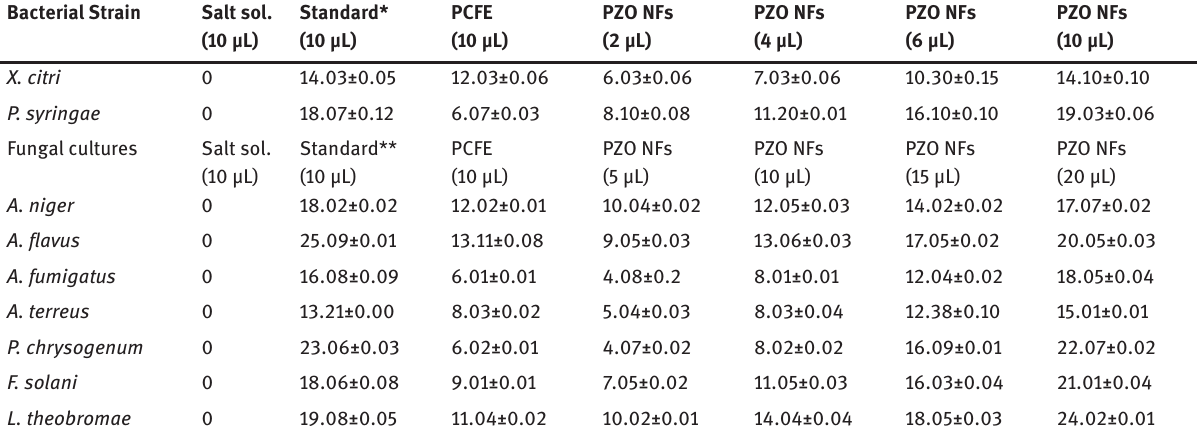
Table 2: In vitro antibacterial and antifungal efficacy of pomosynthesized ZnO nano falcate against plant phytopathogens . Bacterial Strain Salt